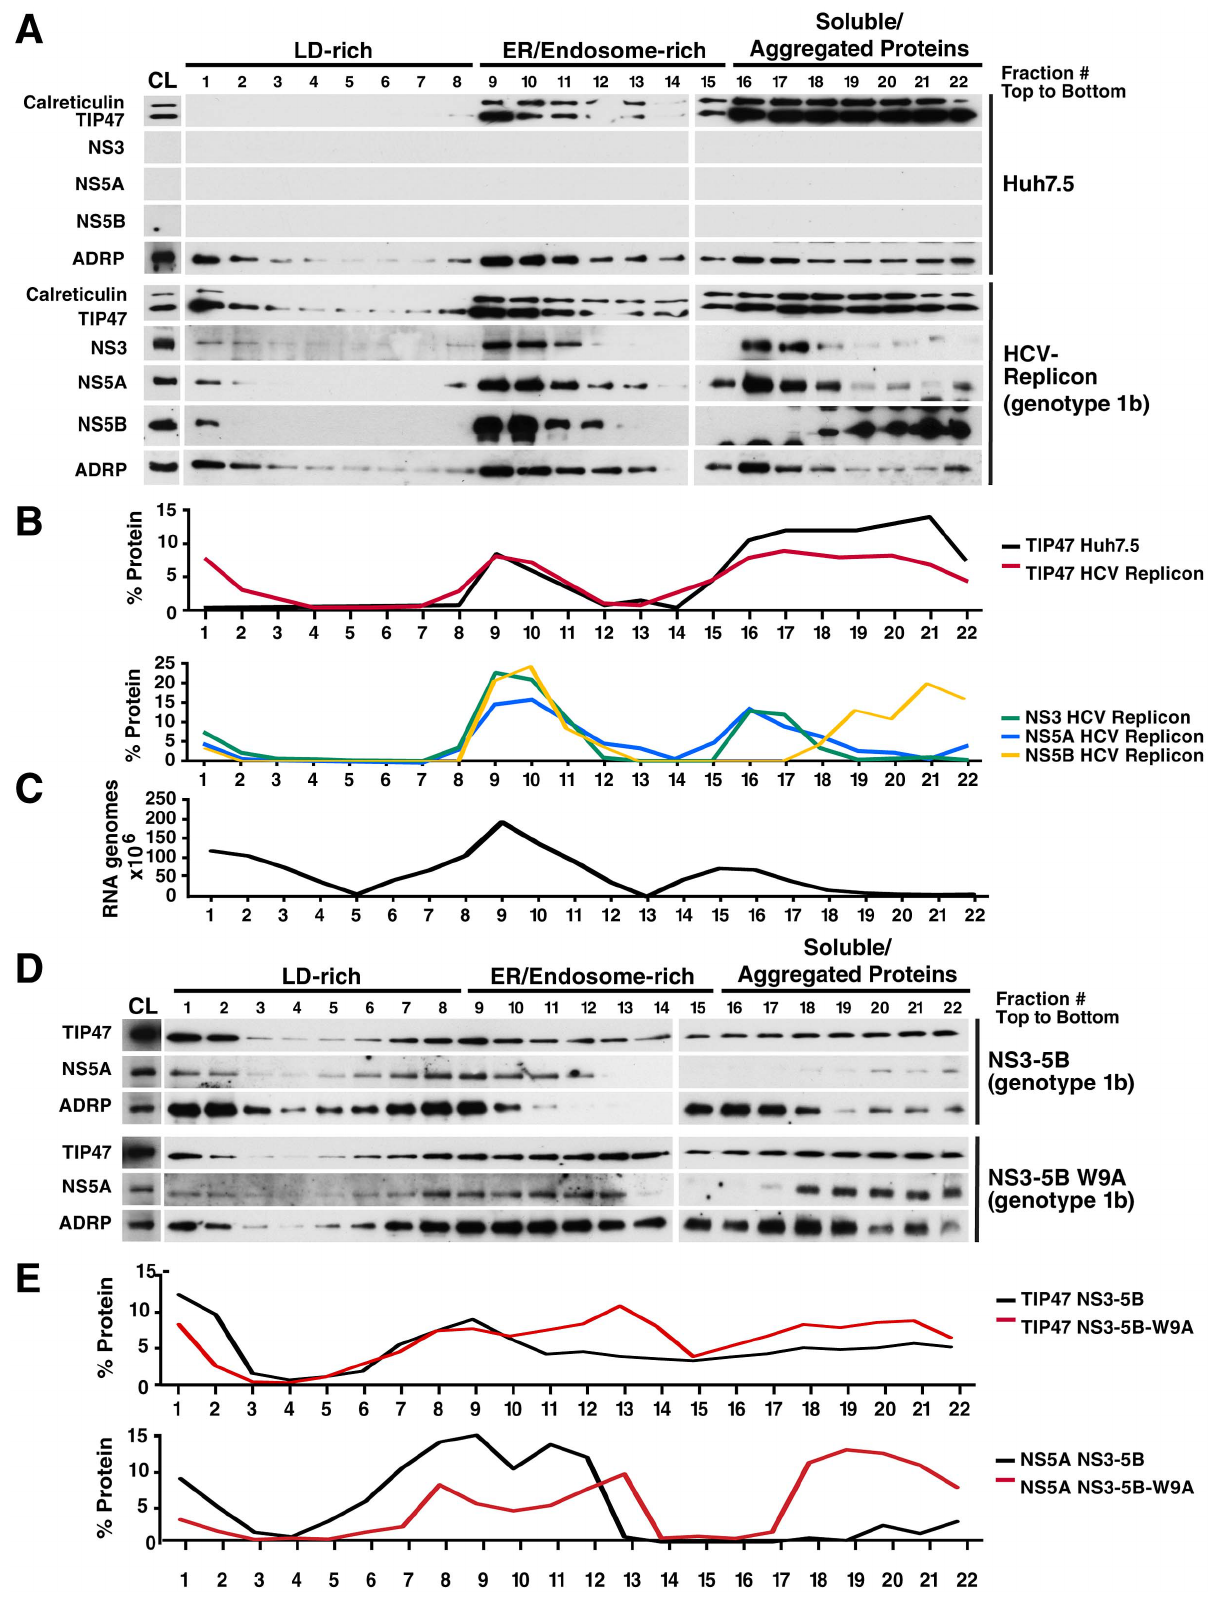
Figure 4. TIP47 cofractionates with lipid droplets, viral nonstructural proteins, and viral RNA during HCV RNA replication. A) Western blot following the membrane flotation assay in an iodixanol gradient. Briefly, cytoplasmic lysates (CL) of either naı¨ve Huh7.5 cells or Huh7.5 cells harboring a subgenomic HCV replicon (genotype 1b) were mixed 1:1 with 60% iodixanol (in PBS/0.25 M sucrose) for a final 30% iodixanol